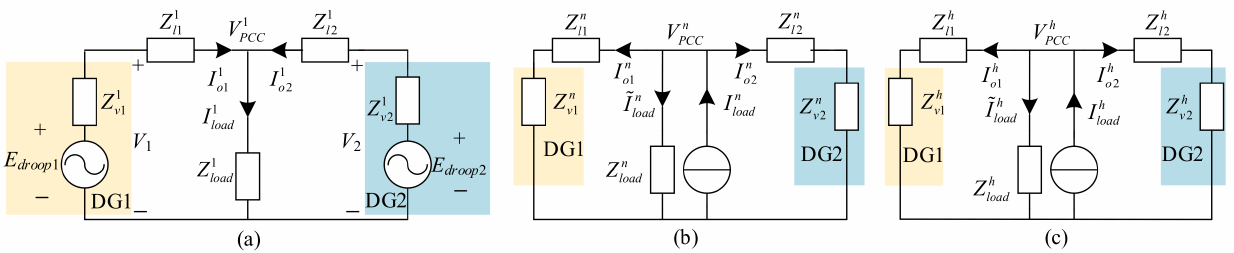
Figure 2. Equivalent circuits of a microgrid at different frequencies and sequences: ( a ) Equivalent circuit at fundamental positive sequence; ( b ) Equivalent circuit at fundamental negative sequence; ( c ) Equivalent circuit at harmonic